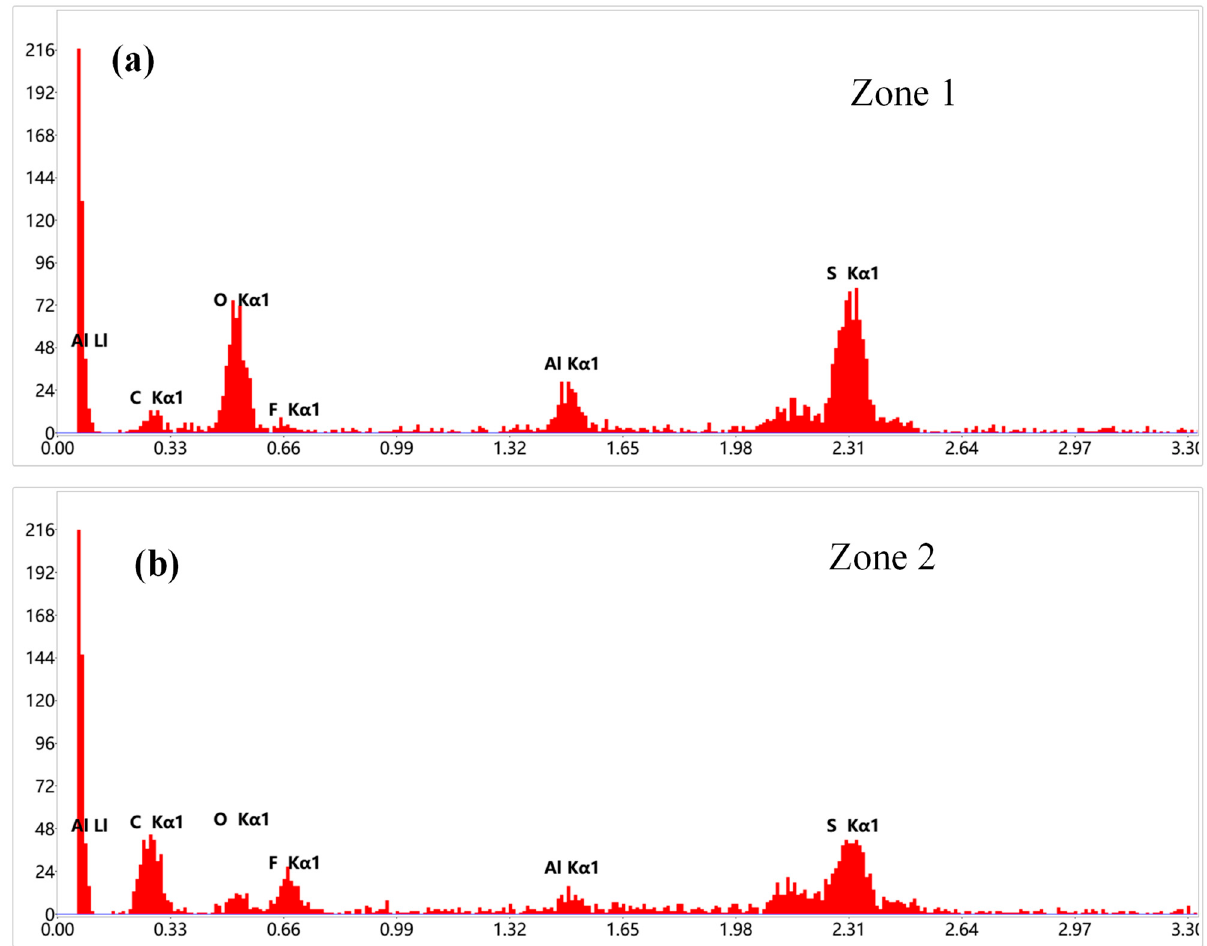
Figure 5. EDS spectra of AC electrodes obtained from the AC//Li half-cell with PCE electrolyte after overcharging to the high voltage of 10.0 V: ( a ) zone 1; ( b ) zone 2.